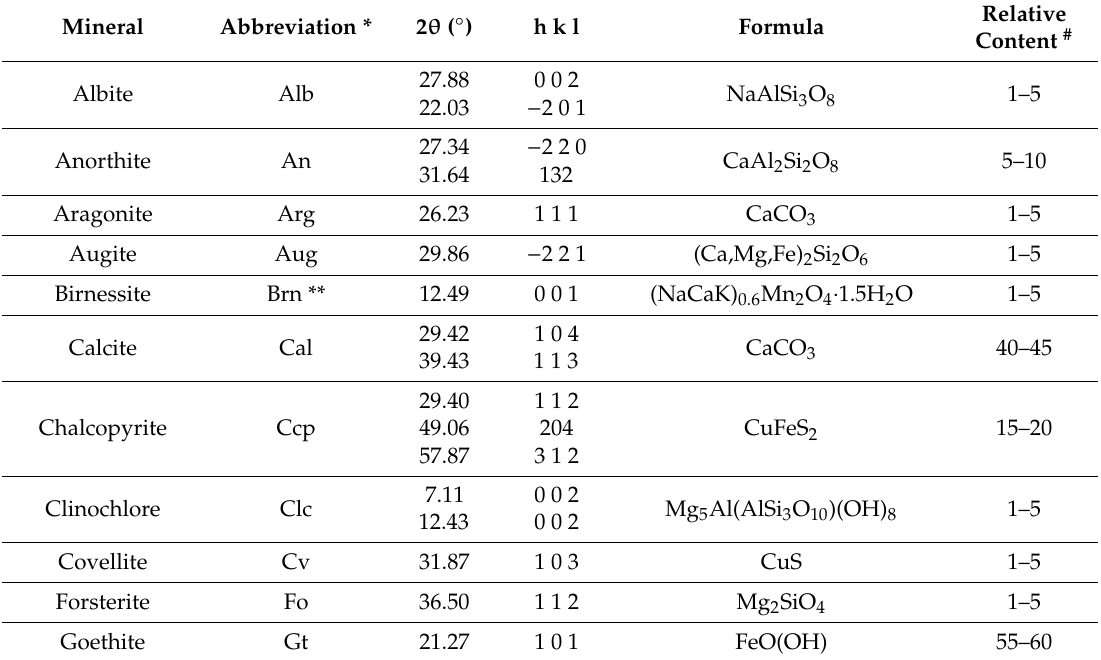
Table 2. Identified mineral phases in the analyzed TAG-sediment